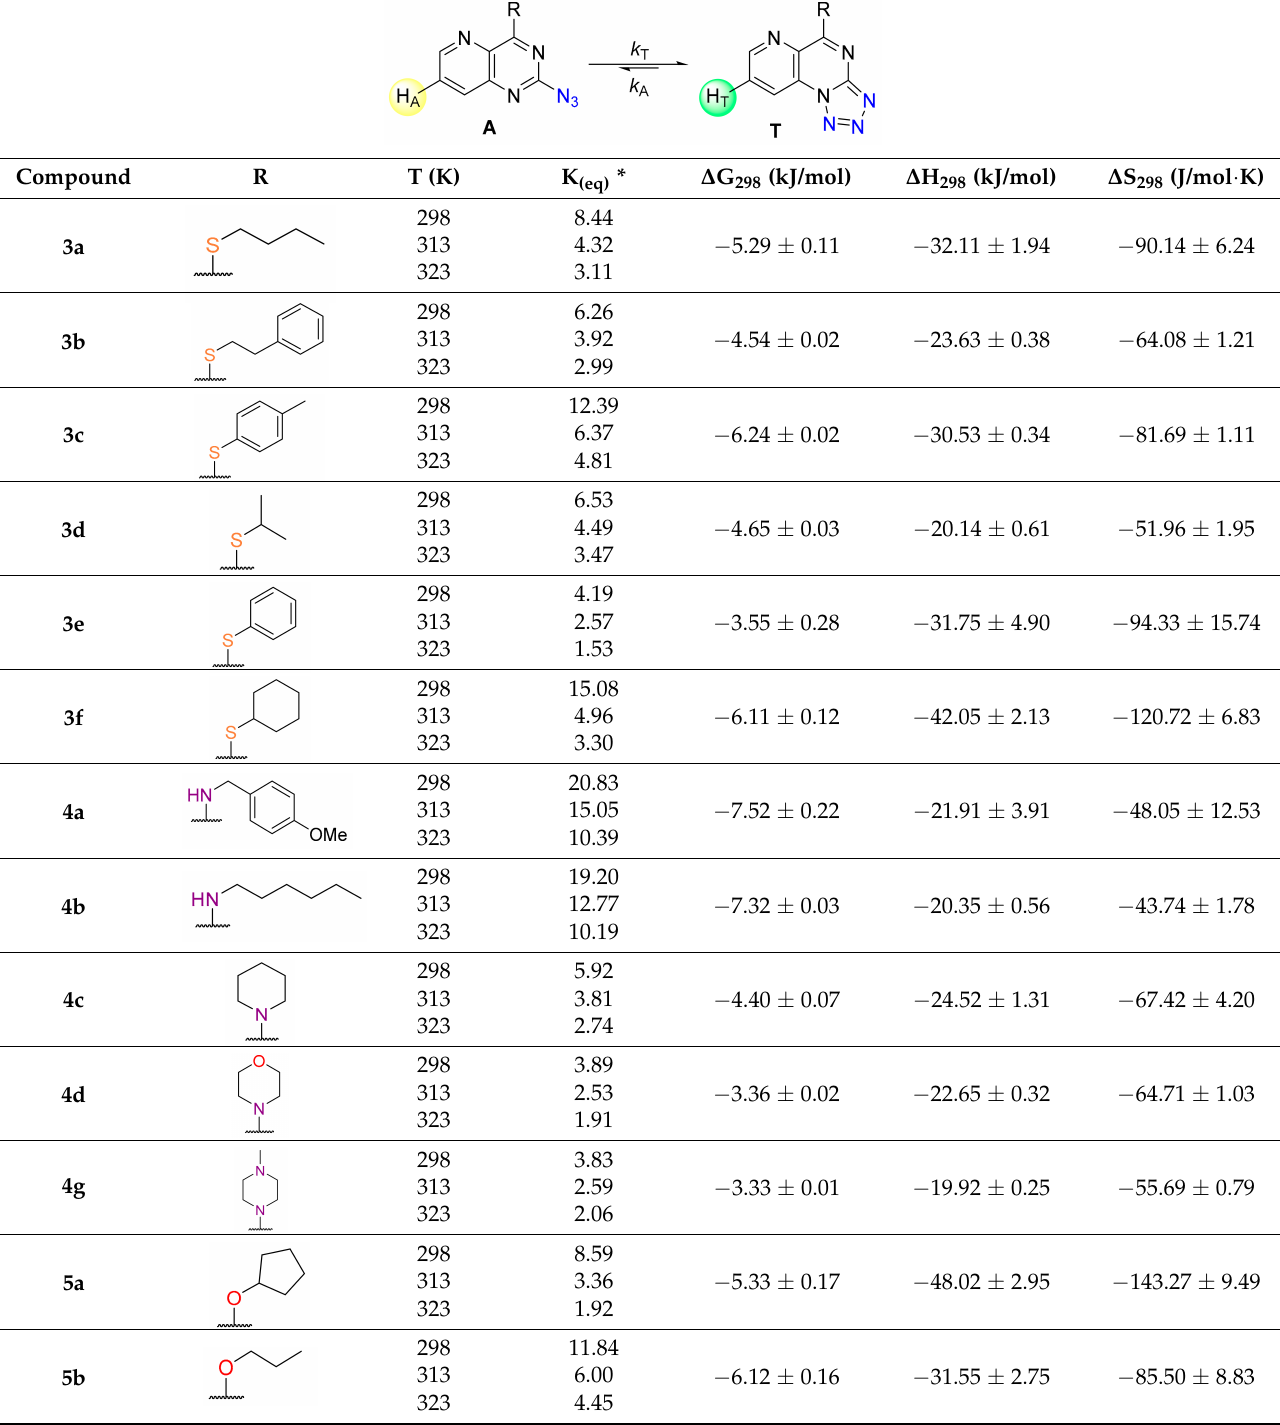
Table 3. Equilibrium constant and thermodynamic heat of the tautomerization of